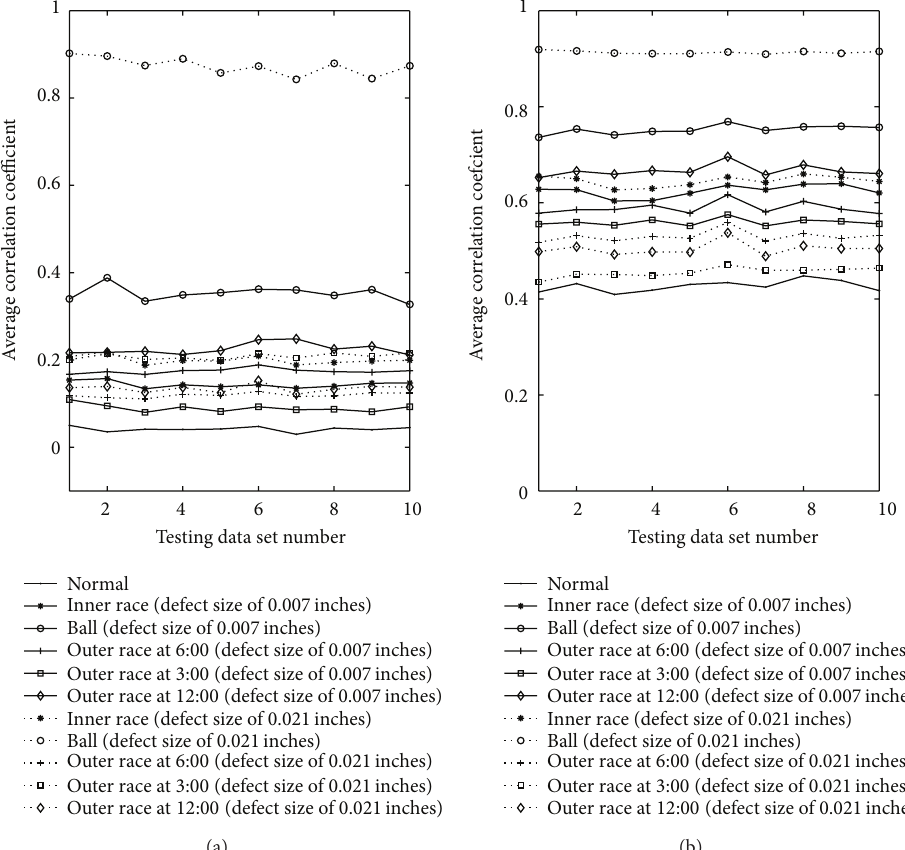
Figure 14: Detection results of ball fault with defect size of 0.021 inches according to morphology spectrum correlation analysis: (a) signal based triangular SE; (b) flat